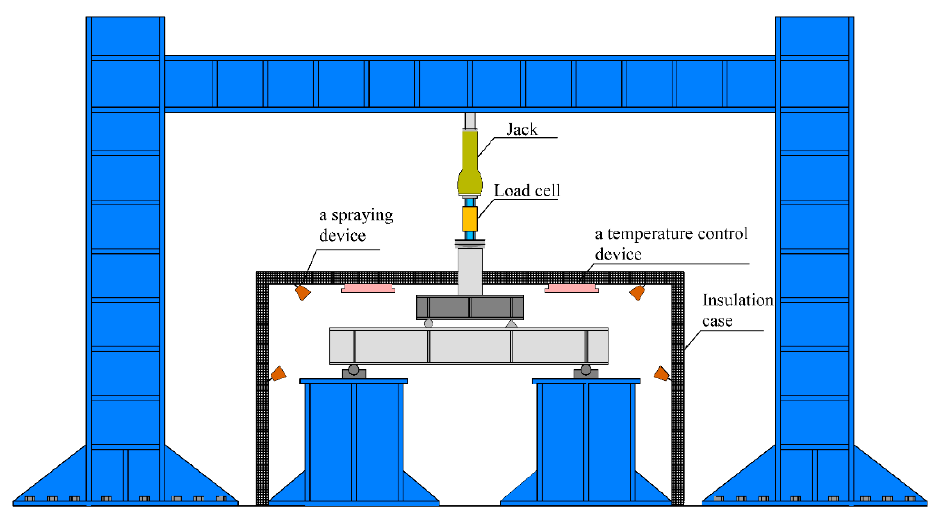
Figure 3. Schematic diagram of corrosion method. Table 2. H-shaped stee beam grouping. Group